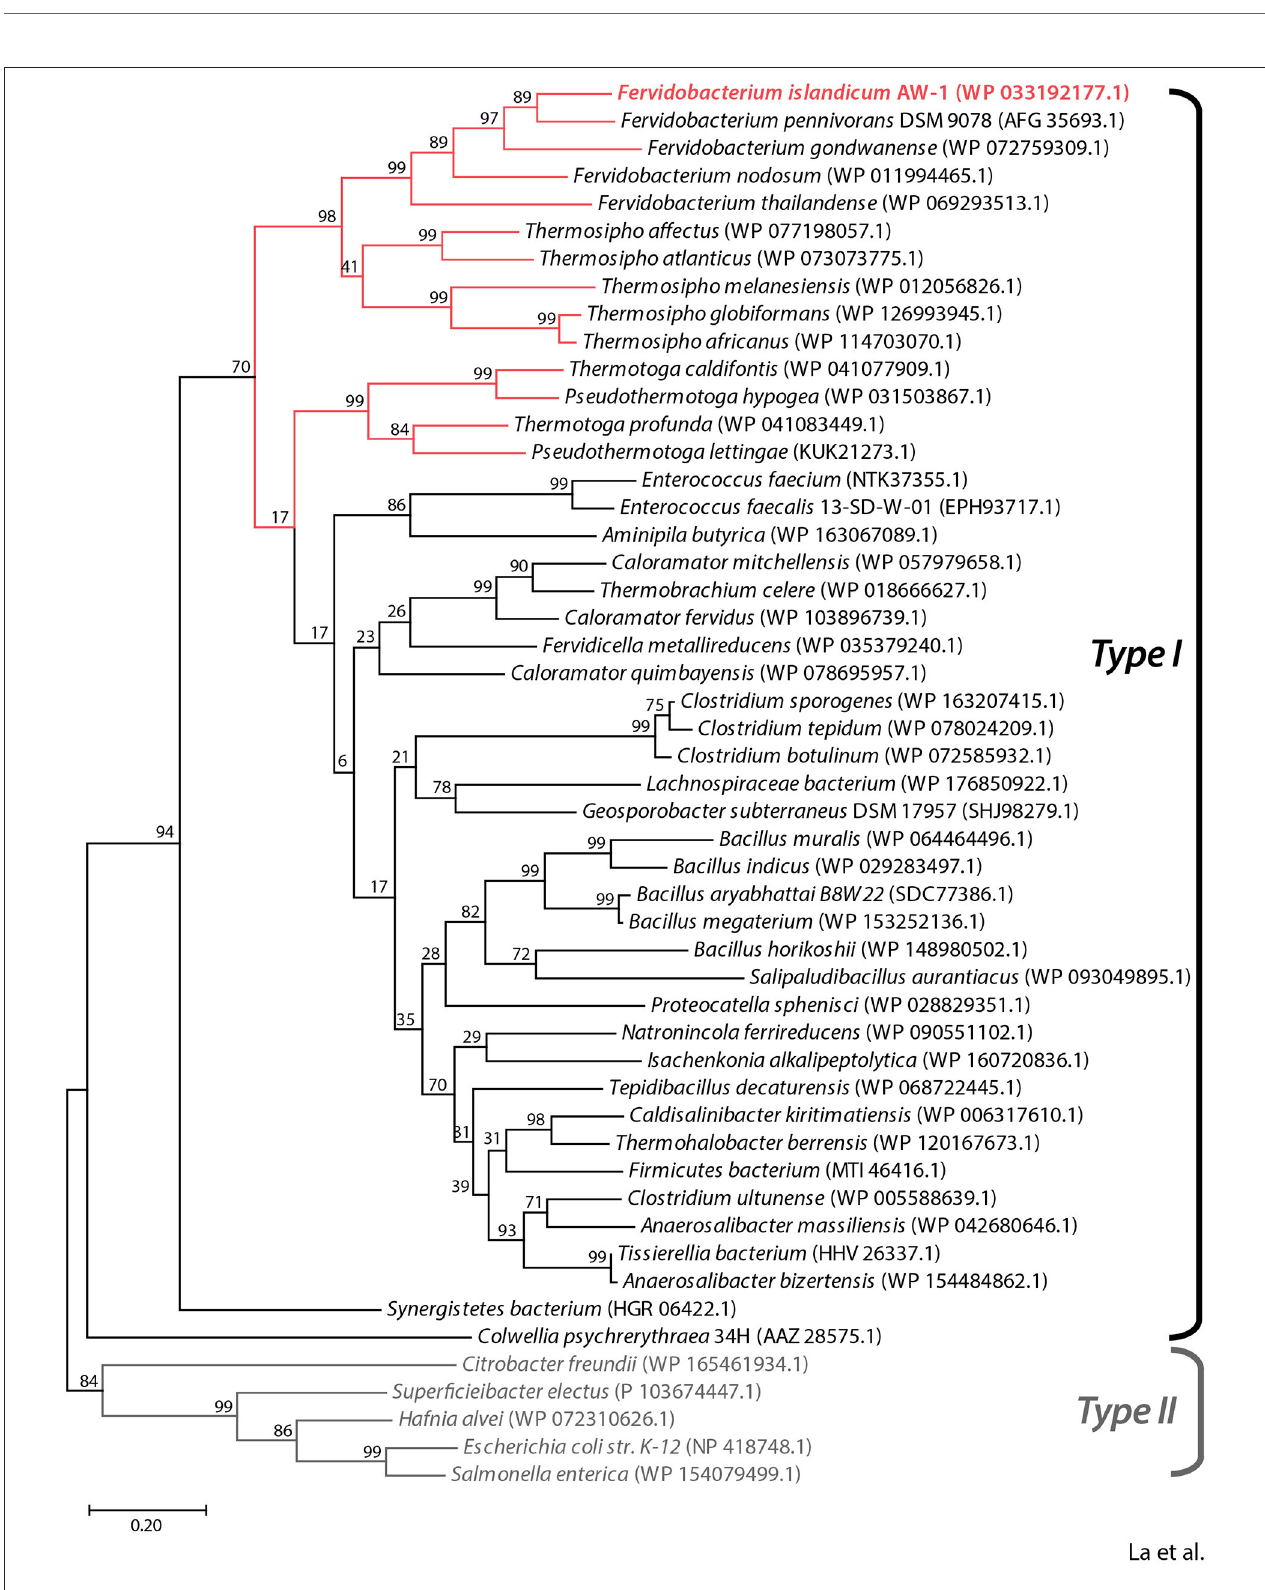
FIGURE 1 | Phylogenetic analysis of Fi BAP and its homologs. The phylogenetic tree was constructed based on protein sequence alignments of Fi BAP and 50 BAP homologs using the maximum likelihood method in MEGA X. Bootstrap values are indicated at the branch points. Red lines indicate BAP derived from hyperthermophilic bacteria. The scale bar indicates a branch length equivalent to 0.2 changes per amino acid. NCBI protein database accession numbers for each individual protein sequence are indicated in parentheses.